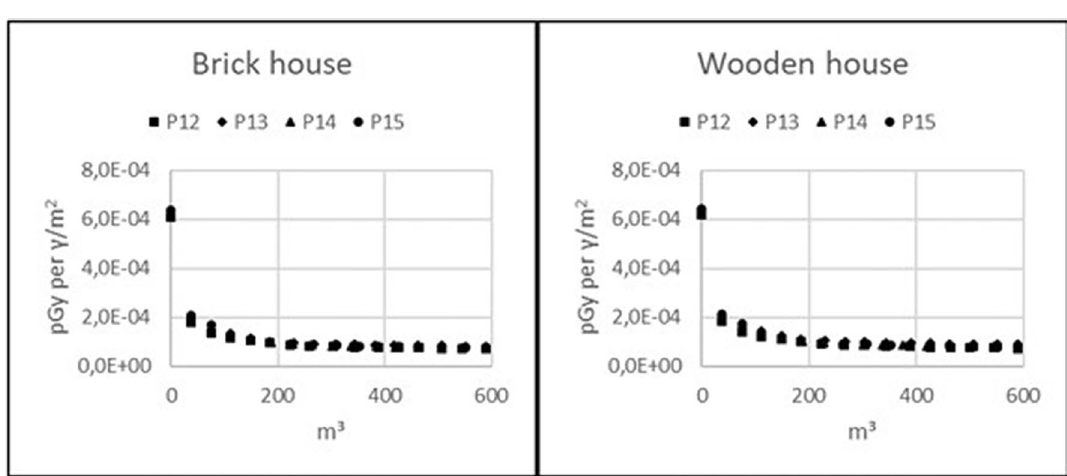
Figure 6. Reduction of absolute radiation exposure per volume of generated waste caused by topsoil removal for observation points outside a brick or a wooden house on properties